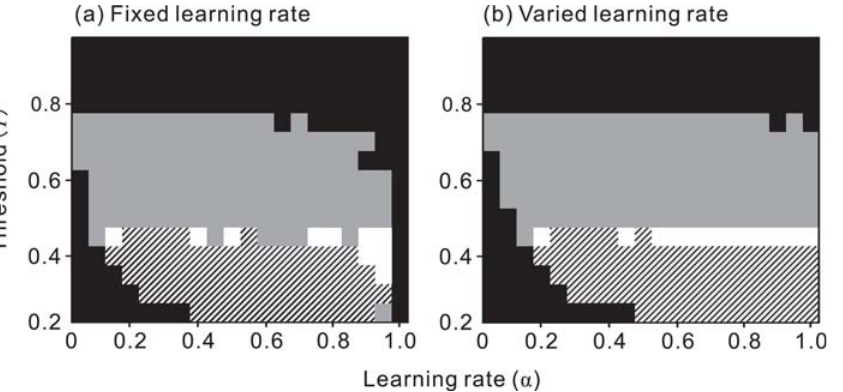
Figure 2. The effect of the learning rate ( a ) and rule of the predator learning, and the availability of alternative prey ( T ), on Model– Mimic relationships. (a) The predator learns the value of prey at the same rate a (fixed learning rate); (b) the predator learns more readily when it encounters highly palatable or unpalatable prey (varied learning rate). Black, no harm; gray, quasi-Mu¨llerian; white, classical dichotomy; and hatched, quasi-Batesian. Huheey’s rule [13,14] in which only the last experience is remembered can be obtained by setting a equal to 1 following the fixed learning rule. The decision making rule of the predator is all-or-nothing (Exps. 3 and 4), X mo =0.2, D mo =0.2, Q =0.02. Notice that predator’s learning ability ( a ) and manner (fixed or varied a ) have much less effect on Model-Mimic relationships than availability of alternatives ( T